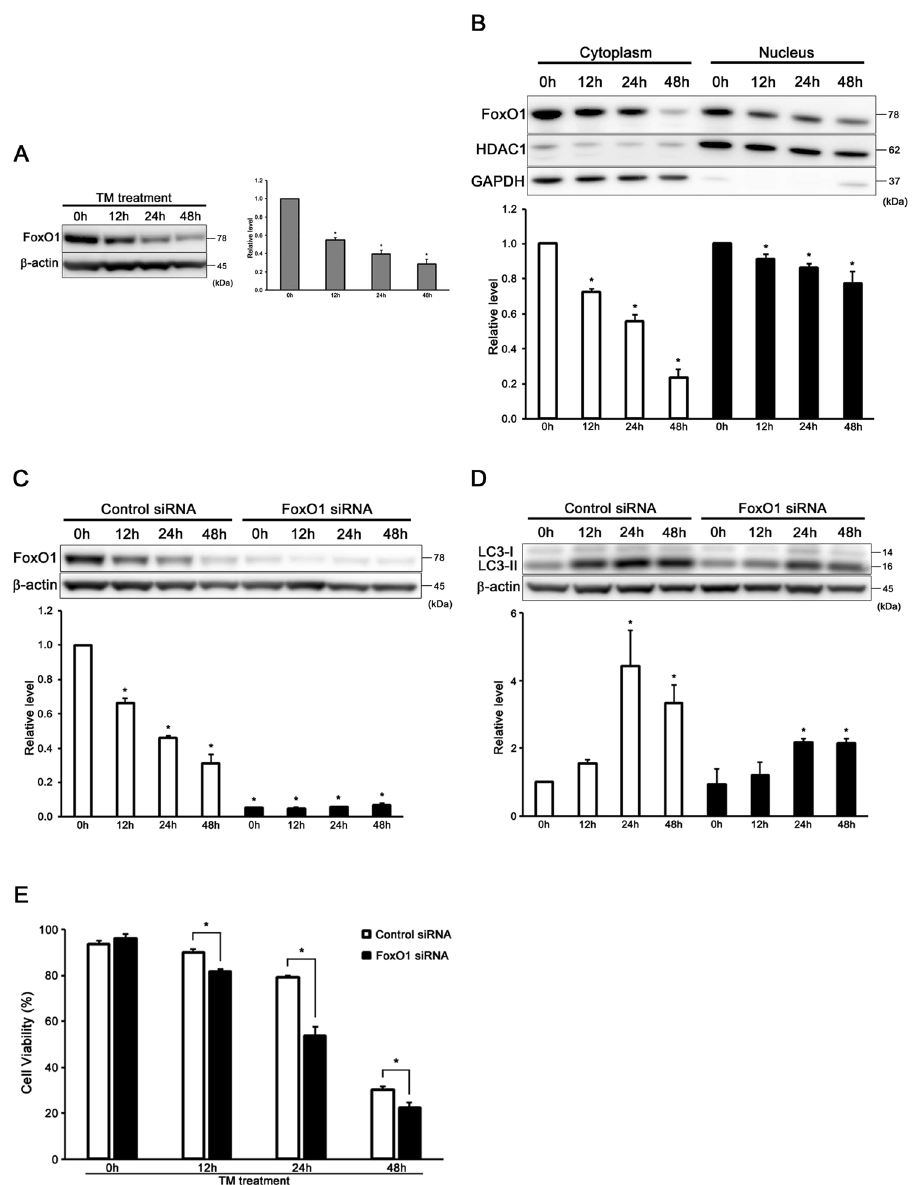
Figure 6. FoxO1 is involved in autophagy in auditory cells under ER stress condition. ( A ) Representative Western blots showing the expression of FoxO1. β -actin was included as a loading control. The expression of FoxO1 was detected, and the means ± S.D. (fold of changes over the control group) of three or more independent studies were presented ( * p < 0.05 versus control group). Full-length blots are presented in Supplementary Figure 6a and b. ( B ) Western blots showing cytoplasmic and intranuclear FoxO1 expression at the designated time after tunicamycin treatment (50 µ g/ml for 48 h). GAPDH was included as a loading cytoplasm control, and HDAC1 was used as a nuclear control. The expression of FoxO1 was detected both in cytoplasm and nucleus. The means ± S.D. (fold of changes over the control group) of three or more independent studies were presented ( * p < 0.05 versus control group). Full-length blots are presented in Supplementary Figure 6c–e. ( C , D ) Knockdown of FoxO1 suppressed the induction of LC3-II. β -actin was included as a loading control. The expressions of FoxO1 and LC3-II were detected, and the mean ± S.D. (fold of changes over the control group) of three or more independent studies were presented ( * p < 0.05 versus control group). Full- length blots are presented in Supplementary Figure 6f–h. ( E ) After transmission with FoxO1 and control siRNA for 48 h, the cells were treated with tunicamycin (50 µ g/ml for 48 h), and cell viability was measured. The data are shown as mean ± S.D. of three or more independent studies ( * p < 0.05 versus control